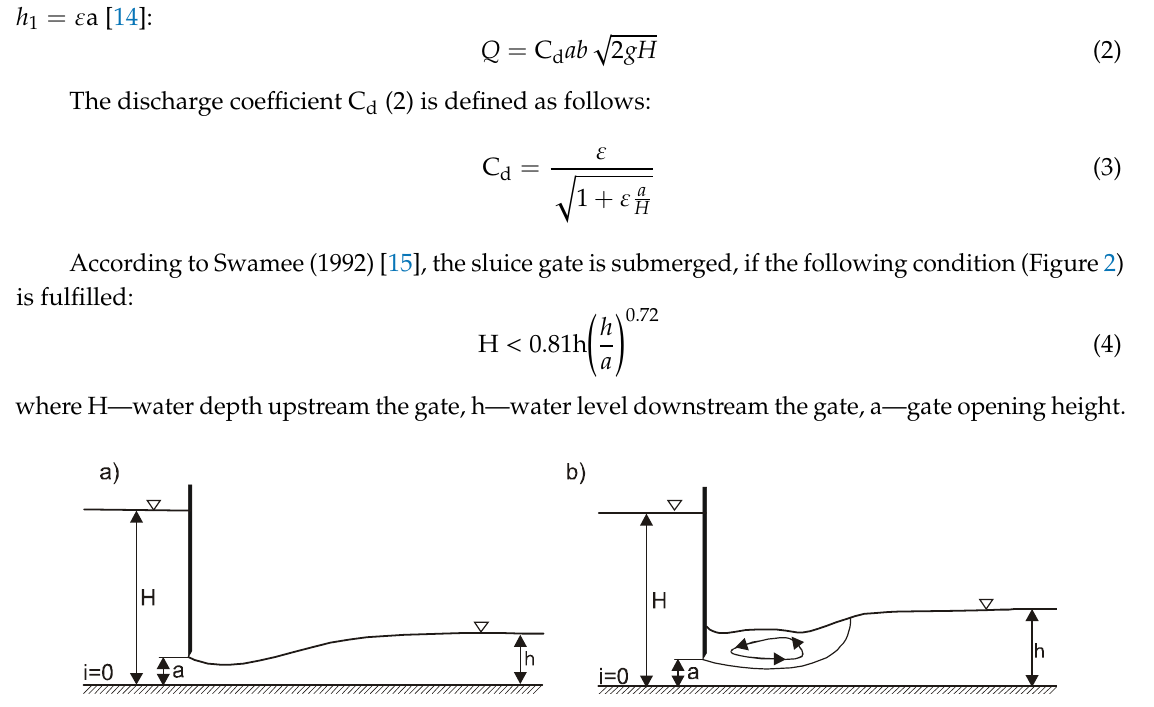
Figure 2. Sluice gate flow: ( a ) free flow at outflow (unsubmerged); ( b ) submerged outflow